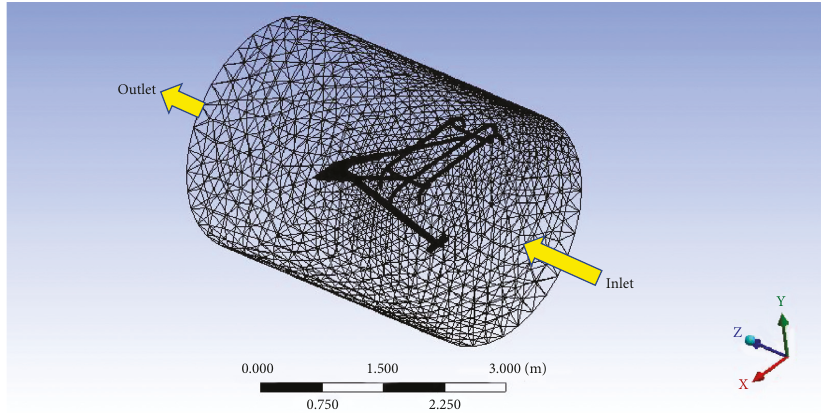
Figure 2: Proposed computational domain for a complete model of the